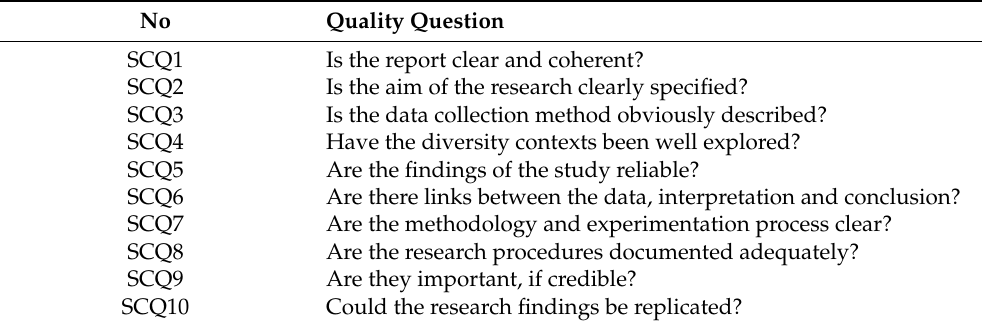
Table 3. Quality